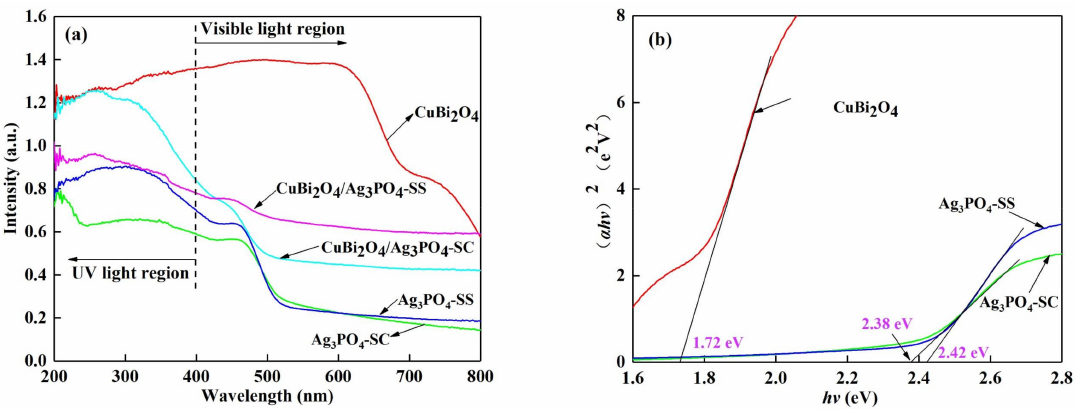
Figure 3. ( a ) UV-Vis diffuse reflectance spectra of the as-prepared materials, ( b ) band gap energy ( E g ) of CuBi 2 O 4 , Ag 3 PO 4 -SC, and Ag 3 PO 4 -SS derived from the plots of ( α hv ) 2 versus energy ( hv ).